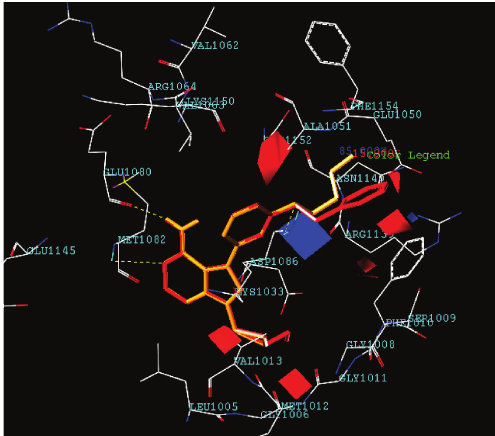
Figure 2: CoMFA electrostatic maps with the most (red) and least (orange) active compound within the active site.